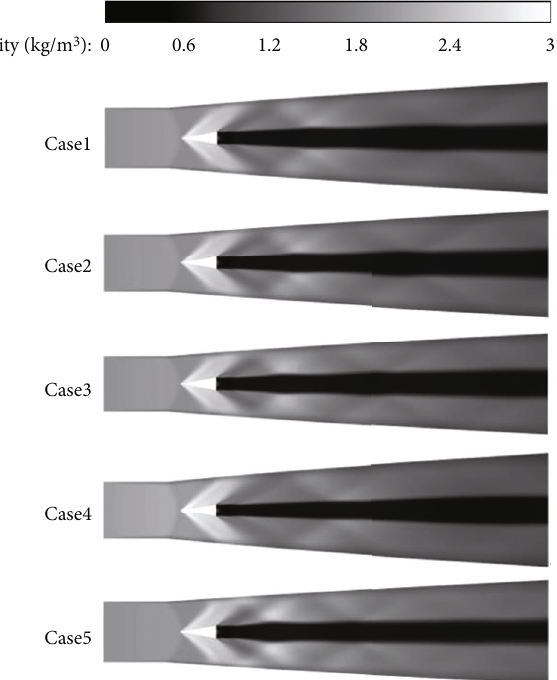
Figure 28: Density distribution for di ff erent cases.